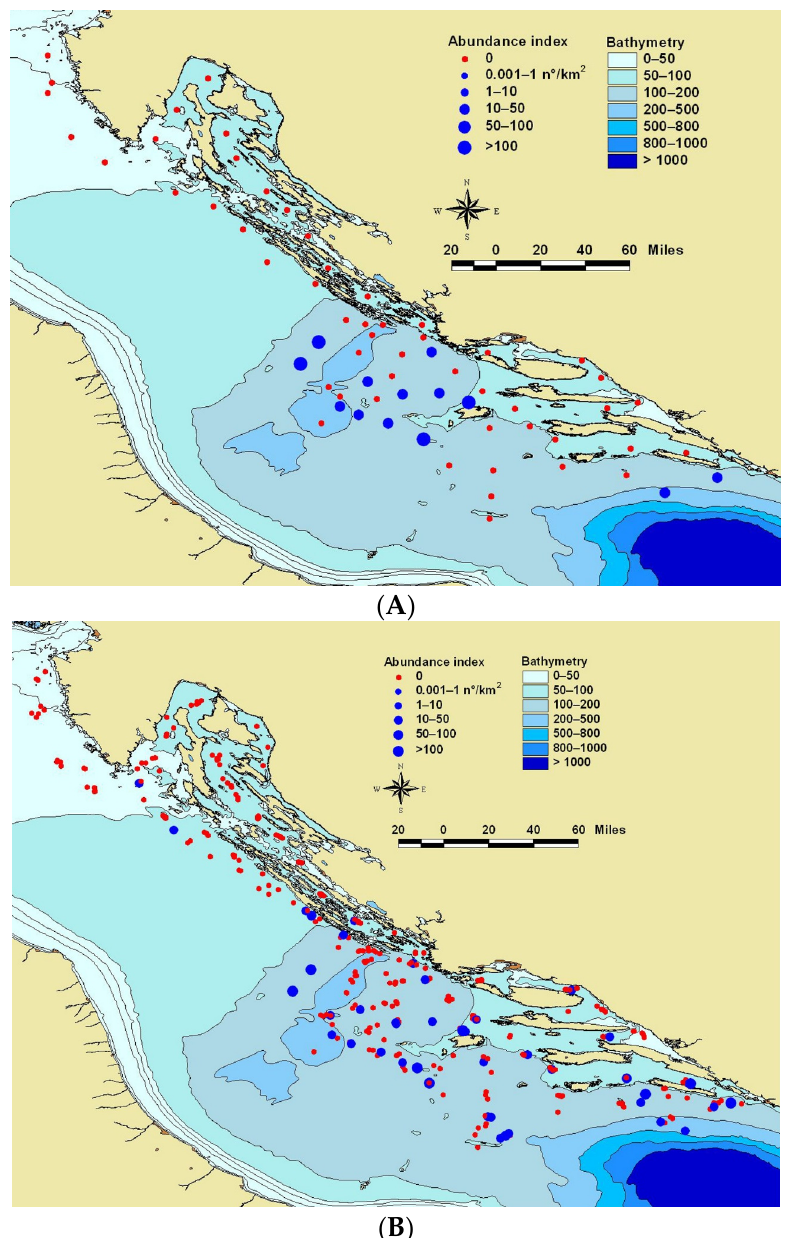
Figure 1. Map of the Adriatic Sea showing the sampling stations of the survey MEDITS done in July 2018 ( A ) and MEDITS surveys done over the last six summers (2013–2018) ( B ) The red (negative stations) and blue (positive stations) dots indicate the sampling stations, where blue dot dimensions varied depending on the number of the blue jack mackerel Trachurus picturatus collected.